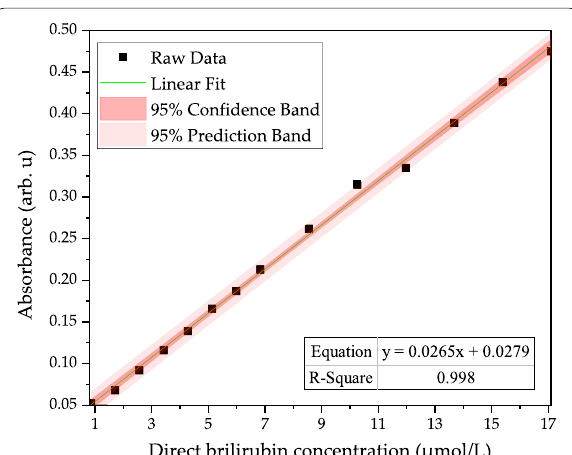
Fig. 4 Absorbance spectrum of direct bilirubin measured by the Hitachi U‑3900 spectrometer